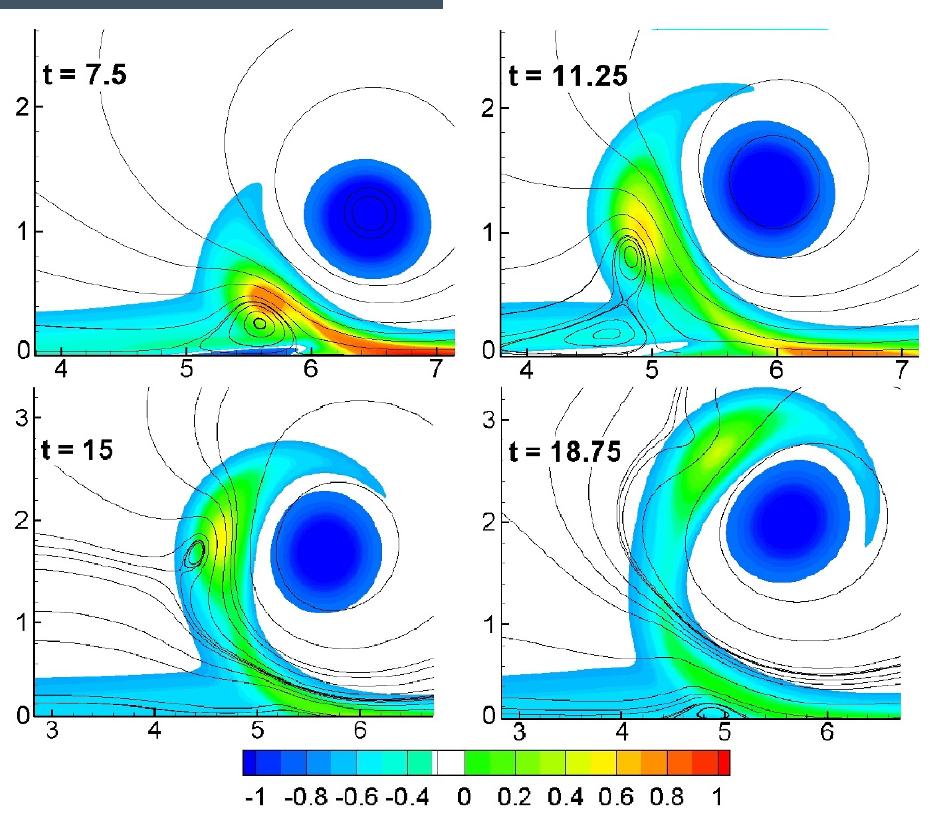
Figure 6. Interaction of the vortex patch and the wall for Re crII = 5000 . The eruption phenomenon takes place in the flow, which predicts a new flow regime. For time t = 15 , a new vortex structure, detached from the wall, is visible. Inside it, the fluid elements from the near-wall region are